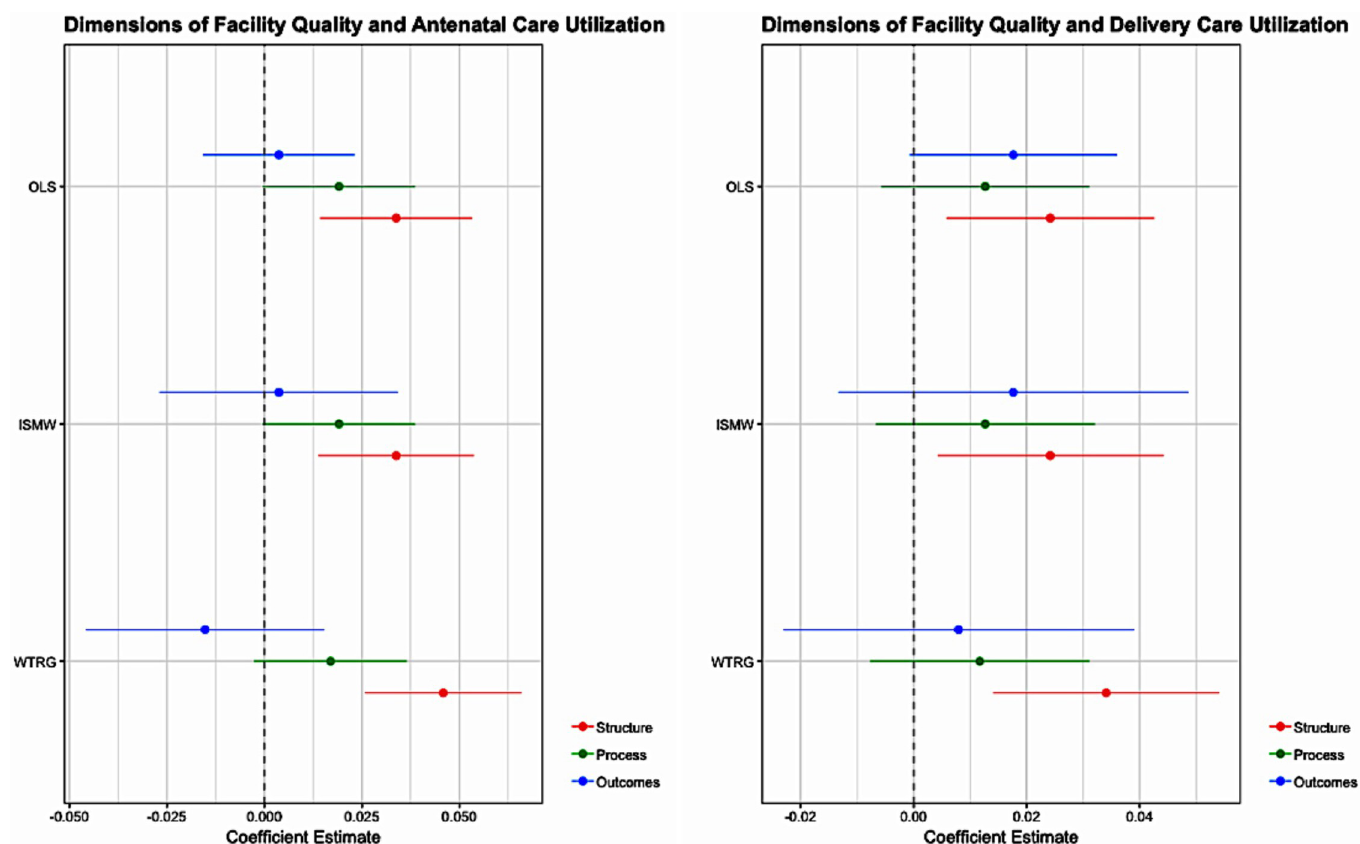
Fig 2. Dimensions of facility quality and obstetric care utilization. The figure shows the OLS, ISMW, and WTRG estimates and 95% confidence intervals of the relationship between structure, process, and outcomes measures of facility quality and antenatal and delivery care utilization based off n = 2,140 deliveries that occurred within 1 year of the facility